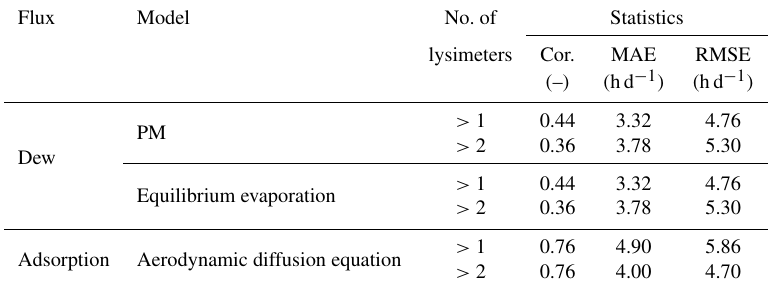
Table F1. Evaluation statistics for the comparison of the occurrence duration between lysimeter measurements and modeling. Dew was modeled based on Penman–Monteith (PM), and the equilibrium evaporation model and adsorption were based on the aerodynamic diffusion equation. Statistics are shown for the options of (i) more than one and (ii) more than two lysimeters measuring dew or adsorption, respectively. Flux Model No. of Statistics lysimeters